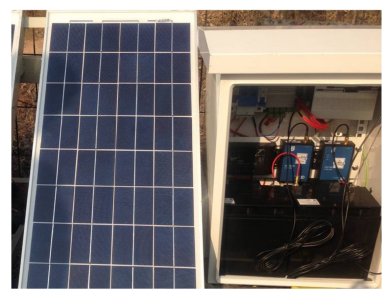
Figure 14. Experimental equipment for each